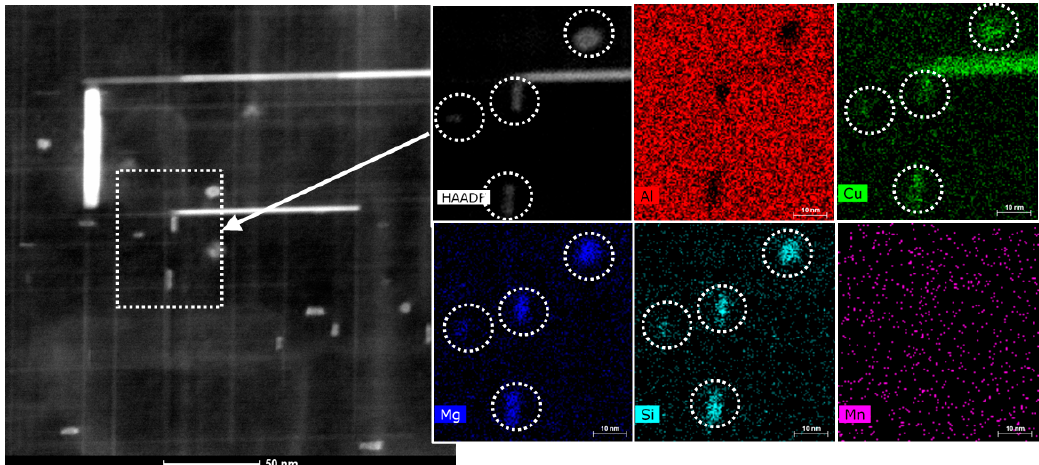
Figure 16. HAADF-STEM images and corresponding EDS mapping of peak-aged Alloy 3 (165 °C/540 min) observed via the <010> Al direction.